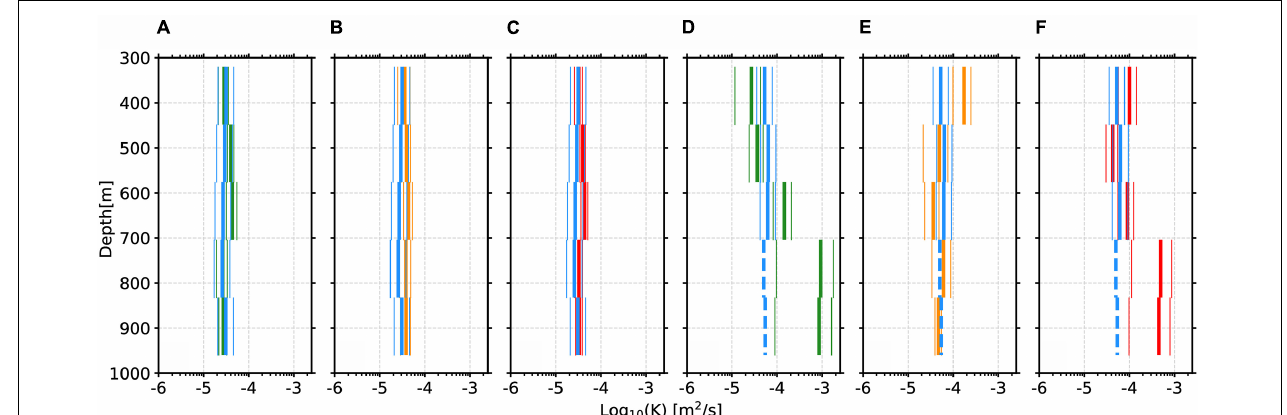
FIGURE 7 | (A–C) Averaged vertical profiles of diffusivity above smooth topography (data from seismic lines 1A–E and CTDs west of 15 ◦ W). Thick blue bars, green bars, orange bars = averaged vertical profiles derived from seismic, GO-SHIP CTD 2003, and 2011, respectively. Red bars = averaged vertical profiles derived from both GO-SHIP 2003 and 2011. Thin bars represent standard errors between CTD profiles or seismic sections. (D–F) Same to (A–C) but above the MAR (data from seismic line 1F and the three eastern most CTDs from GO-SHIP 2003 and 2011). Dashed blue lines represent unreliable diffusivities calculated from regions contaminated by